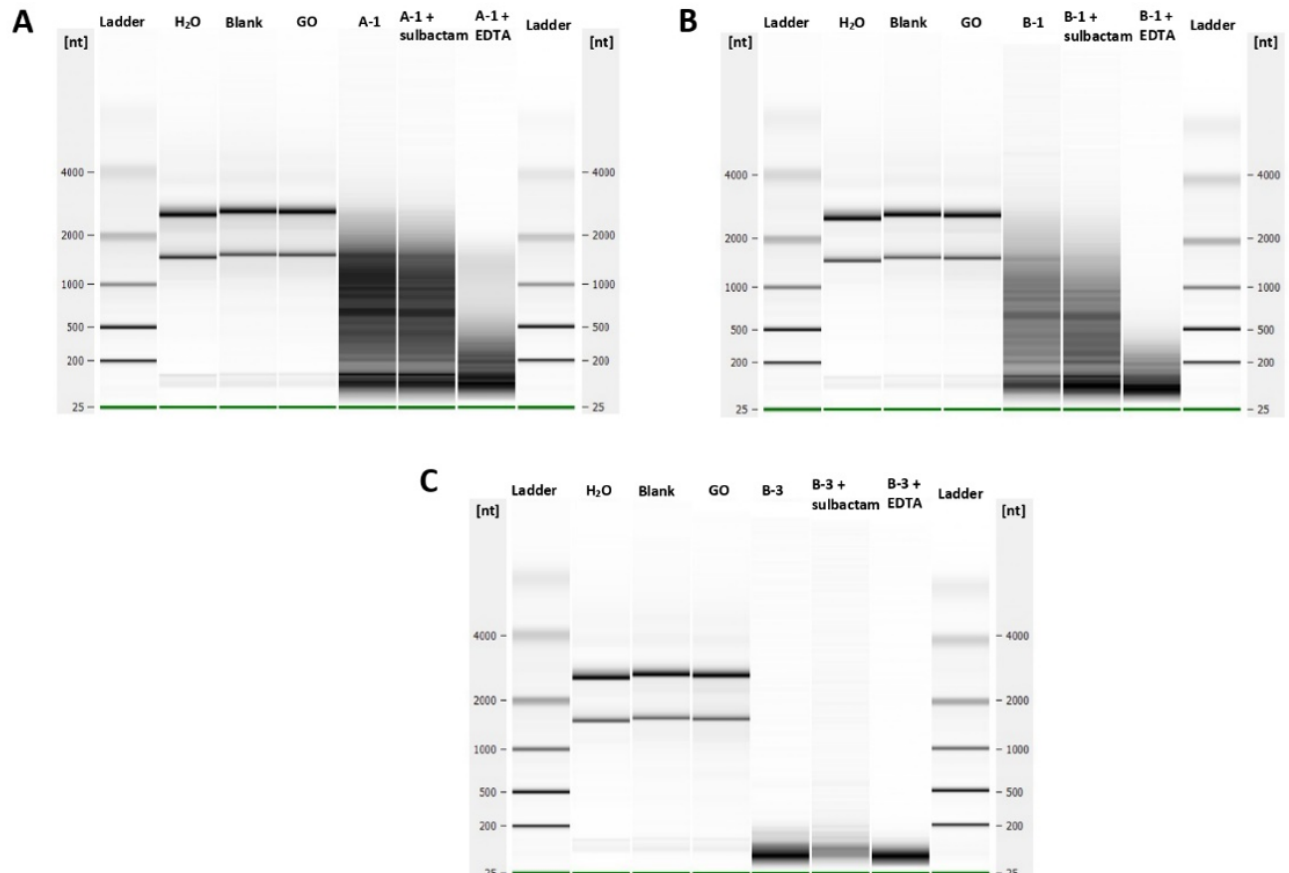
Figure 2. Ribonuclease activities of the purified CPR tested proteins. ( A ) Degradation of bacterial total RNAs by the A-1 CPR enzyme, ( B ) B-1 CPR enzyme, and ( C ) B-3 CPR enzyme in the presence and absence of a metallo-beta-lactamase inhibitor (sulbactam and EDTA). GO (glycine oxidase) was used as a negative control enzyme.